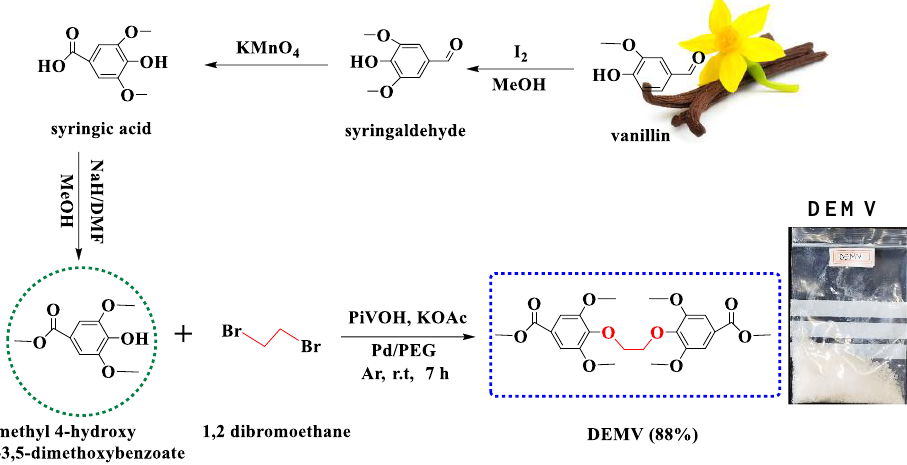
Figure 3. Synthesis of symmetrical biphenyl diester (DEMV).